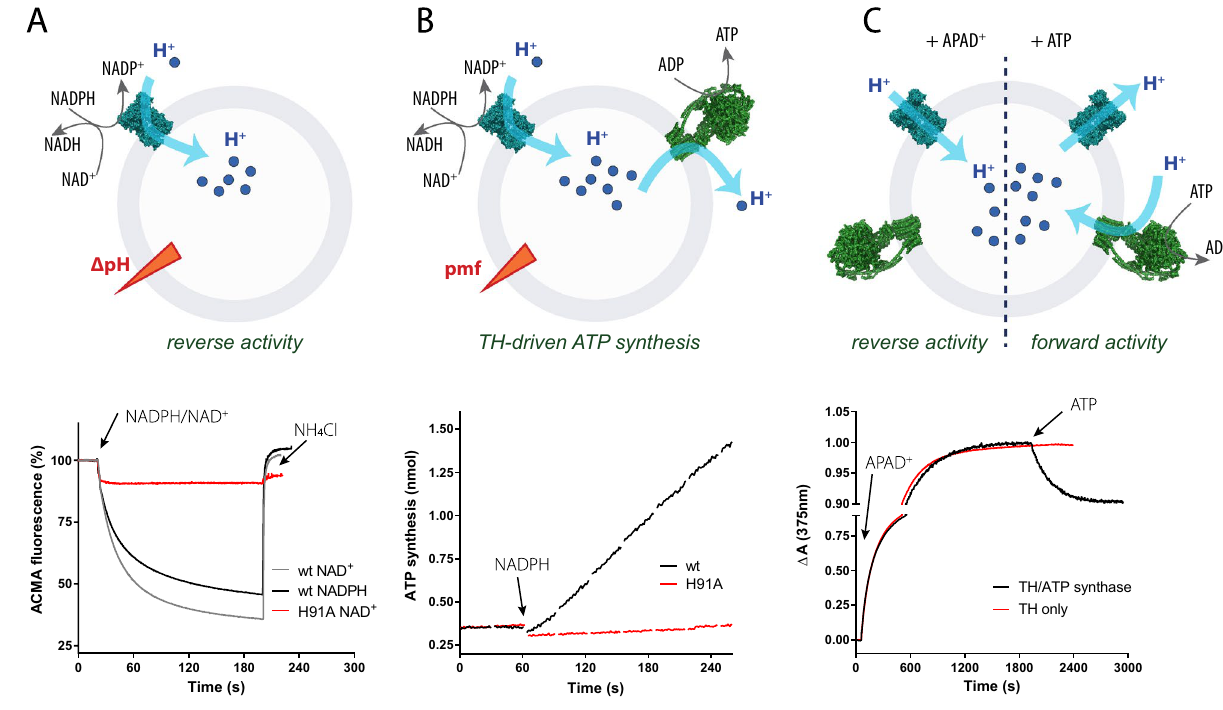
Figure 3. Reverse activity of EcTH in reconstituted systems. ( A ) Proton pumping of reconstituted transhydrogenase during reverse activity was measured following ACMA fluorescence in 1.5 ml 50